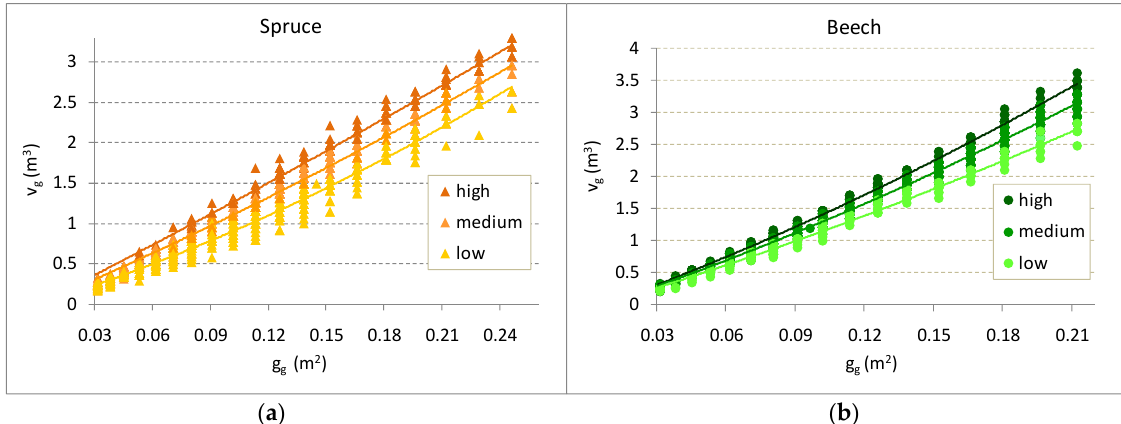
Figure 5. Relationship between Rhg g and age ( a ) and between Rhg g and average diameter ( d g ) ( b ) in beech.